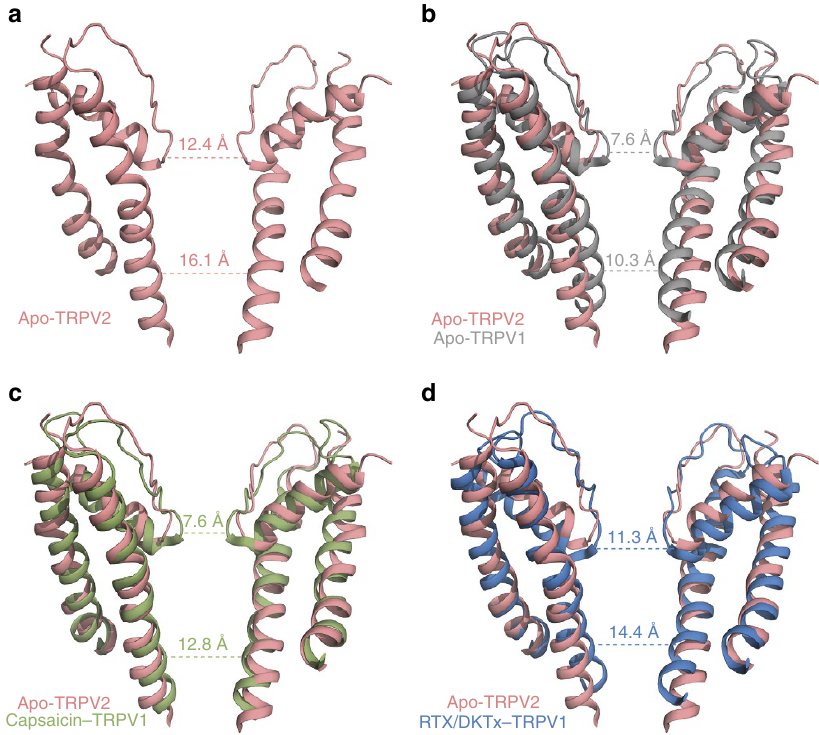
Figure 2 | Analysis of the TRPV2 ion permeation pathway. ( a ) Atomic model of the S5–P–S6 region of apo-TRPV2. Two subunits are shown for clarity. The dotted lines show the C a –C a distances in the apo-TRPV2 structure, which represent the narrowest points in the upper and lower gates. ( b – d ) Atomic model of the S5–P–S6 region of apo-TRPV2 (salmon) superimposed onto the ( b ) apo-TRPV1 structure (grey, PDB: 3J5P), ( c ) capsaicin–TRPV1 structure (green, PDB: 3J5R) and ( d ) RTX/DkTx–TRPV1 structure (blue, PDB: 3J5Q). The dotted lines show the C a –C a distances at the narrowest points in the upper and lower gates of the TRPV1